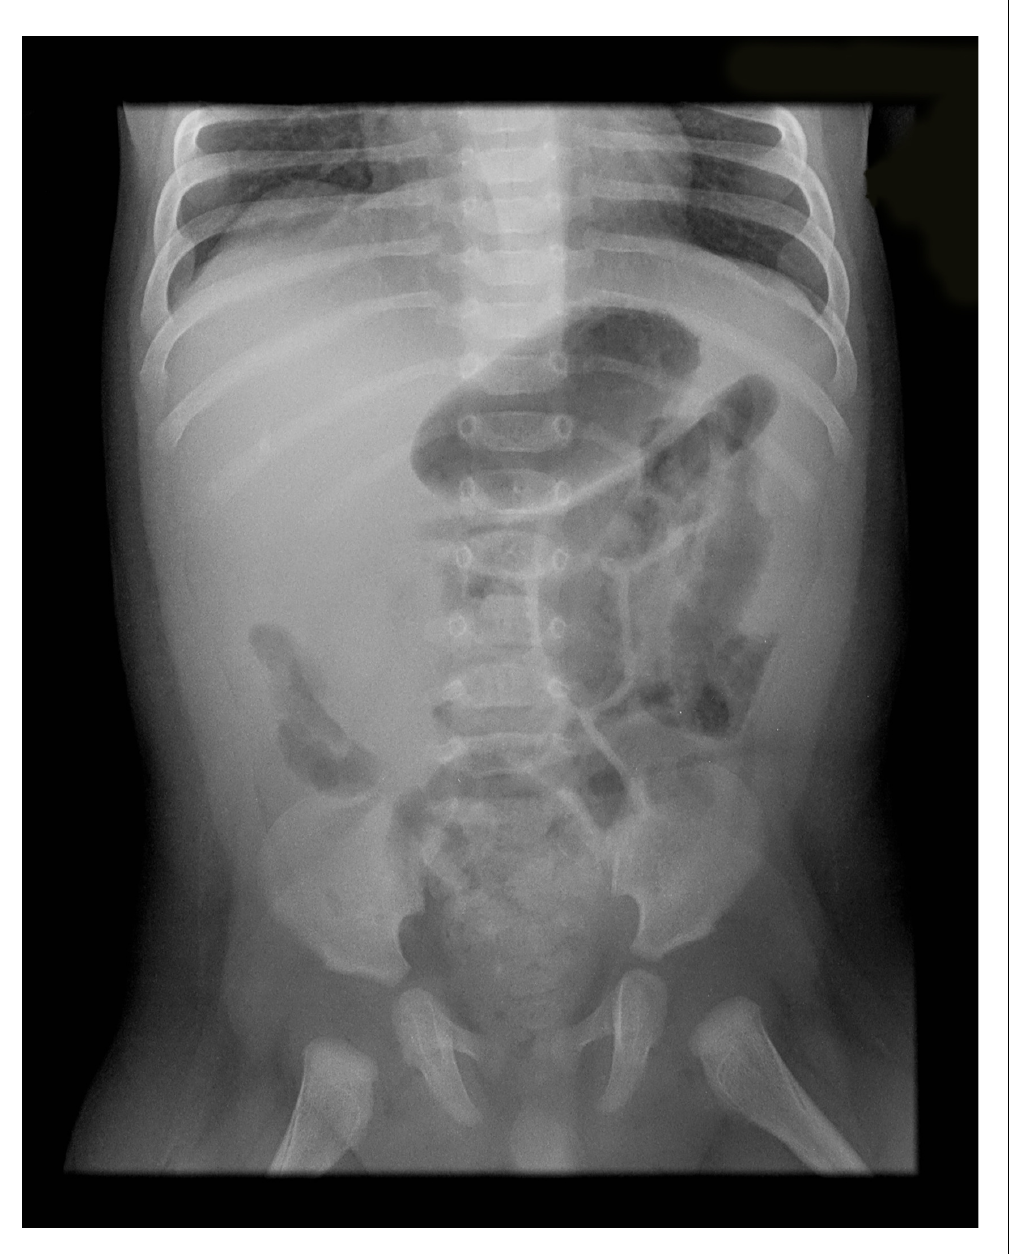
Figure 1. Abdominal X-ray showing small bowel